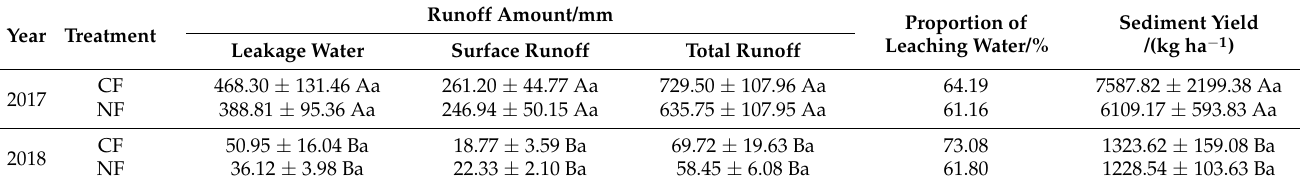
Table 1. Loss amount of runoff and sediment in peanut-growing season.